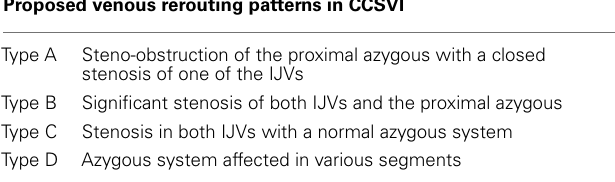
Table 2 | Four proposed principle patterns of venous rerouting in CCSVI in MS (Zamboni et al.,